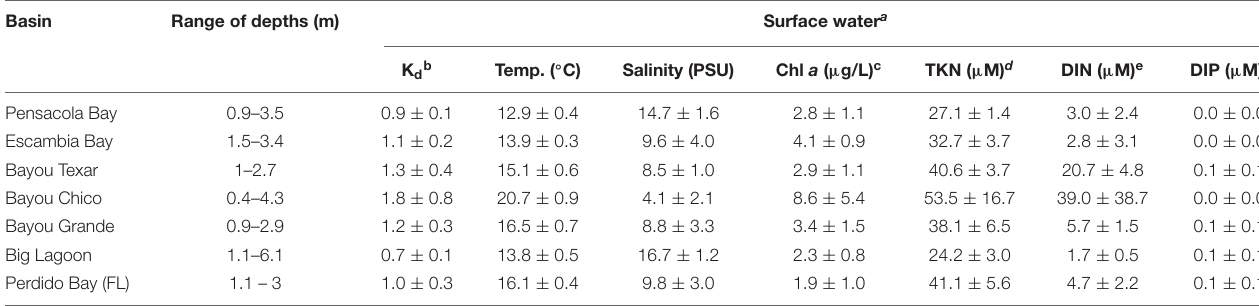
TABLE 1A | Means and ranges of physical and chemical parameters of surface water. Basin Range of depths (m)